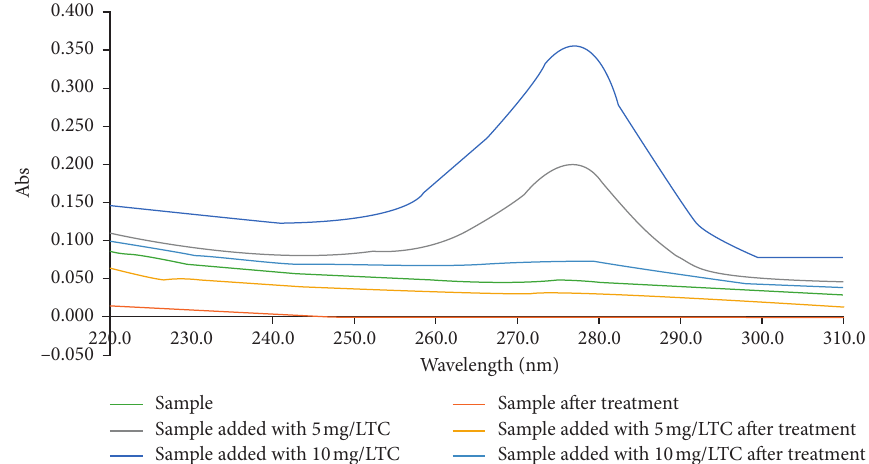
Figure 13: The UV-Vis spectrum of TC antibiotic in a water sample collected from aquaculture pond before and after treatment using NCPML.